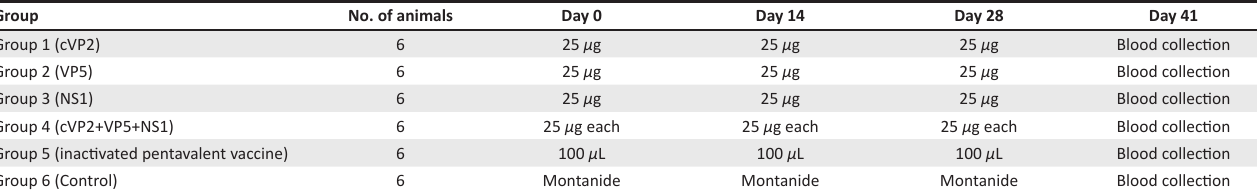
TABLE 1: Protocol of mice immunisation. Group